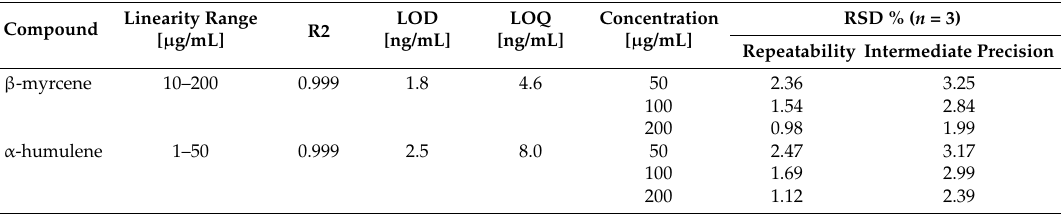
Table 3. Calibration data as well as repeatability and intermediate precision for analyzing β -myrcene and α -humulene by GC-MS/MS system.